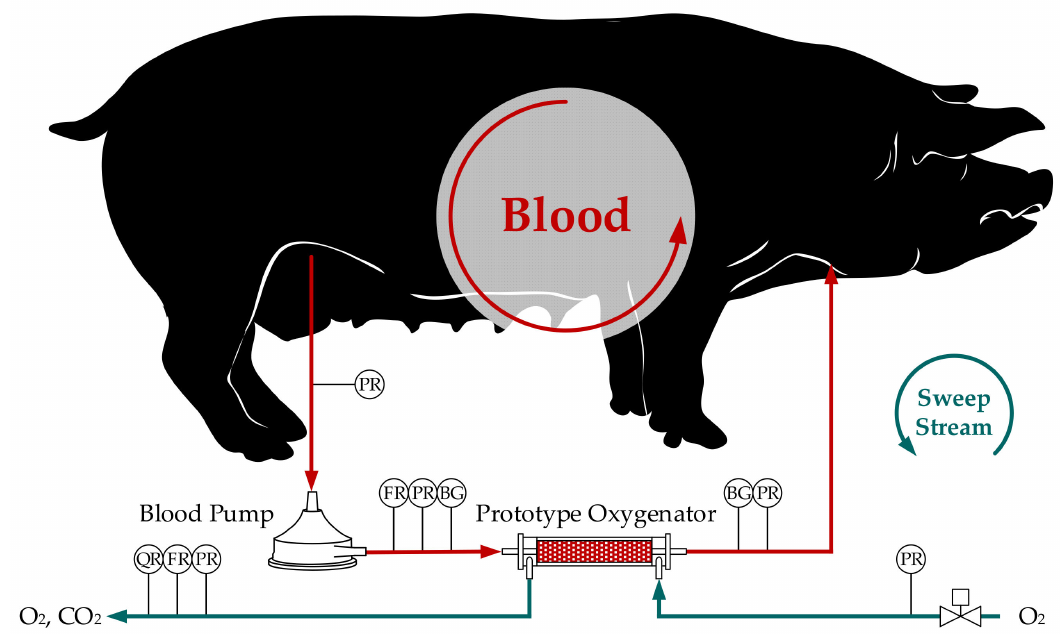
Figure 2. Scheme of the in vivo test setup with prototype oxygenator, blood pump, pressure sensors (PR), flow rate sensors (FR), BGA sample ports (BG) and CO 2 concentration sensor (QR)–by Lukitsch et al. [18], (CC BY